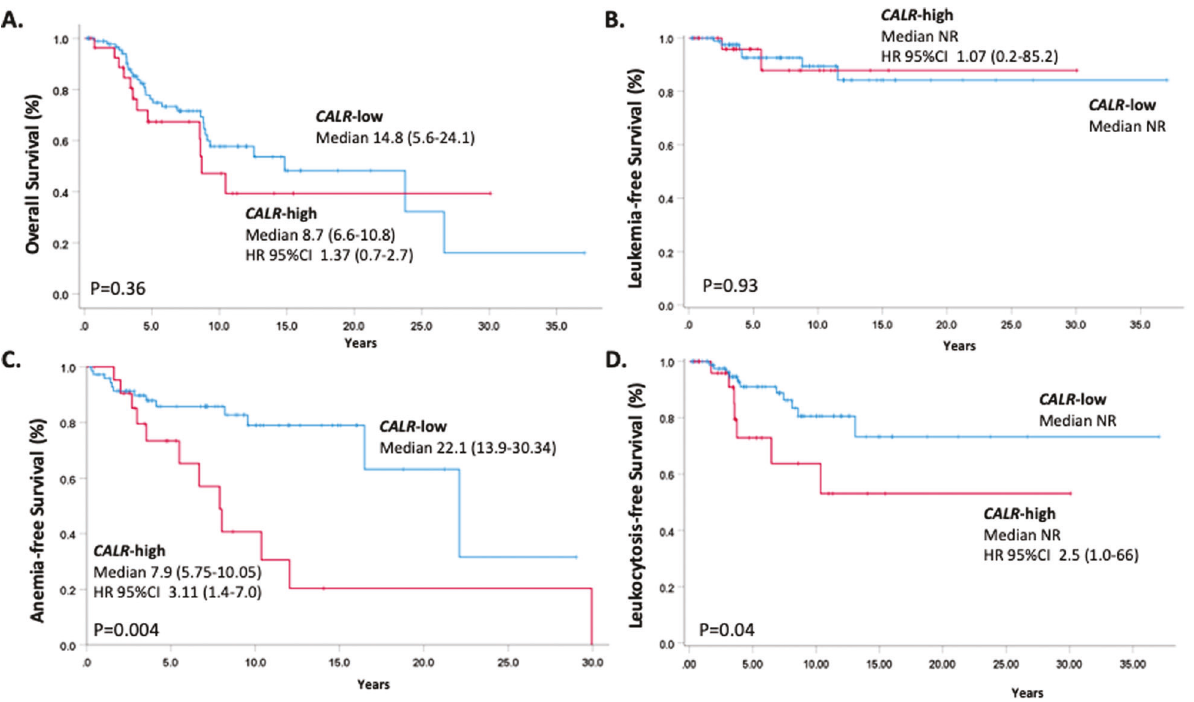
Fig. 1 Impact of CALR mutation variant allele frequency on outcomes in myelo fi brosis. Kaplan – Meier analysis of Overall Survival (panel A ), Leukemia-free Survival (panel B ), Anemia-free Survival (panel C ) and Leukocytosis-free Survival (panel D ) in CALR-mutated patients according to their high and low variant allele frequency burden. Please refer to text for de fi nitions and details. HR 95% CI, hazard ratio, 95% con fi dence